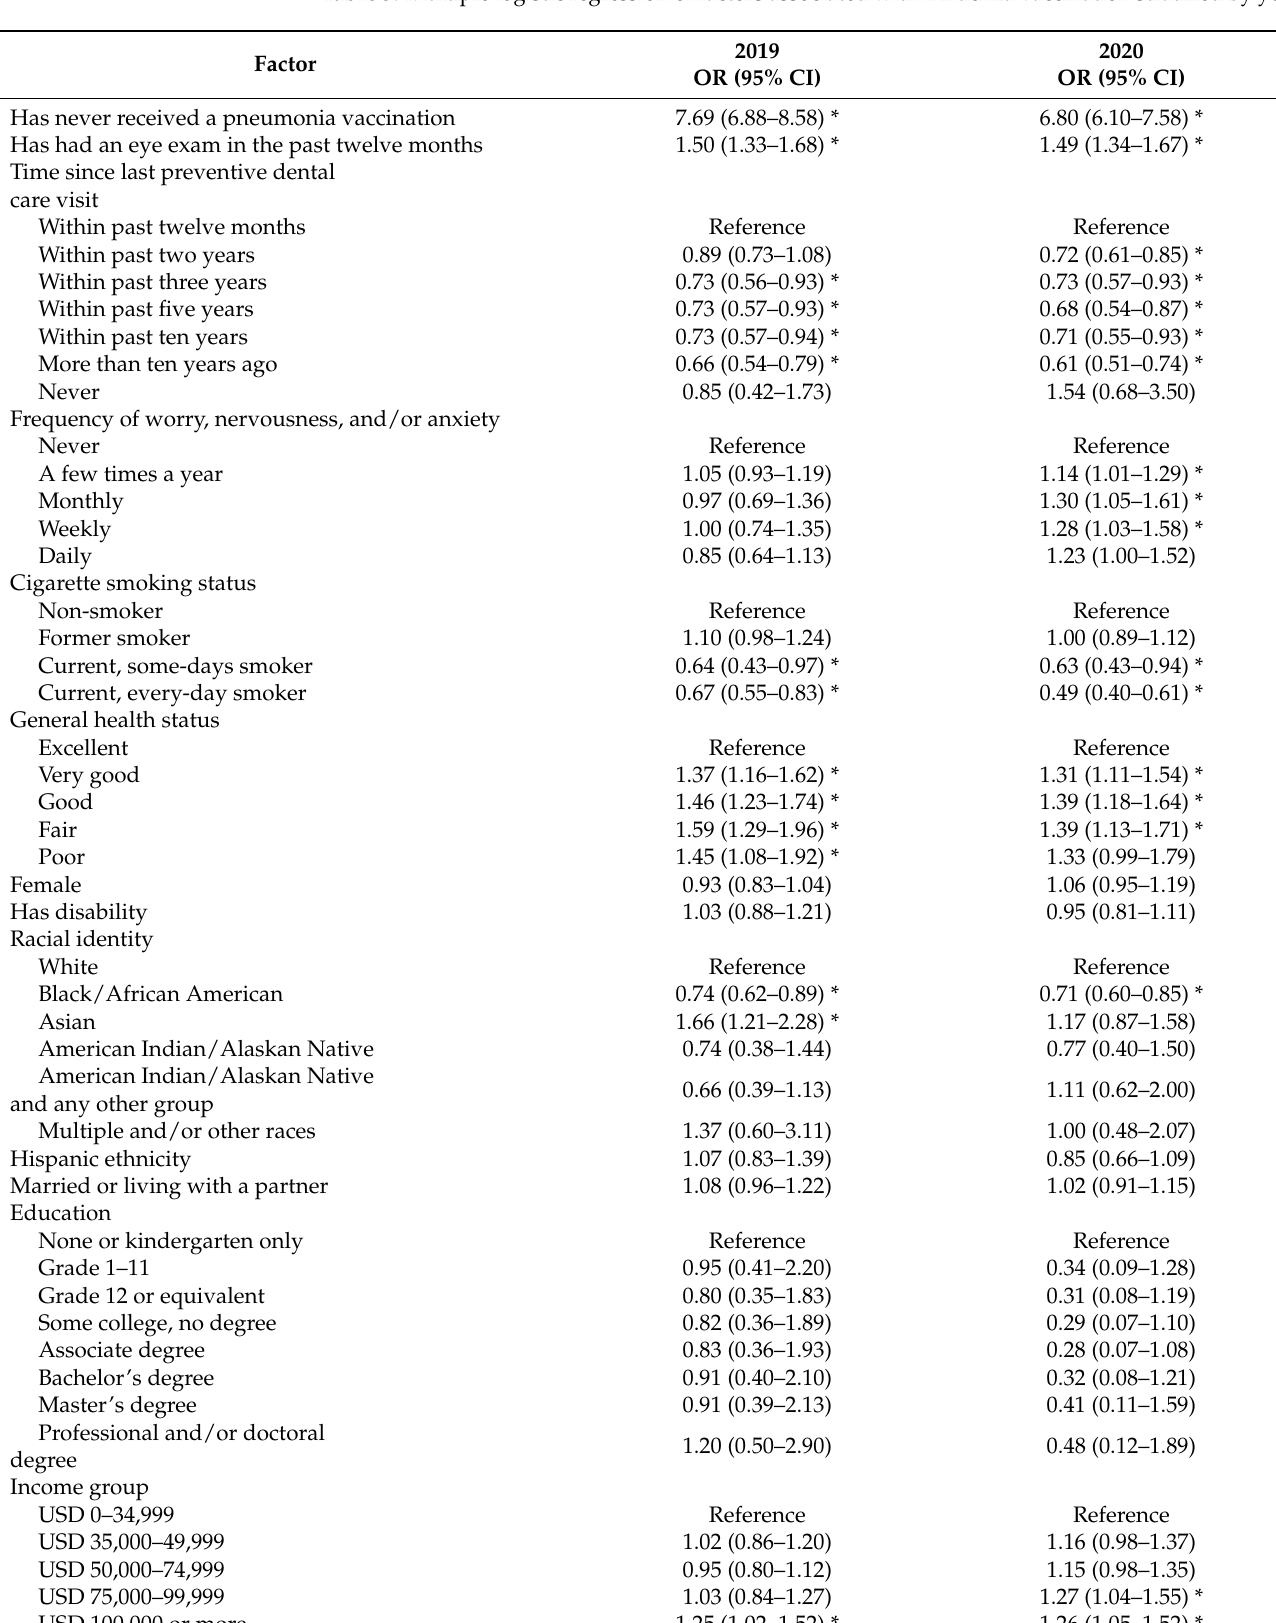
Table 3. Multiple logistic regression of factors associated with influenza vaccination stratified by